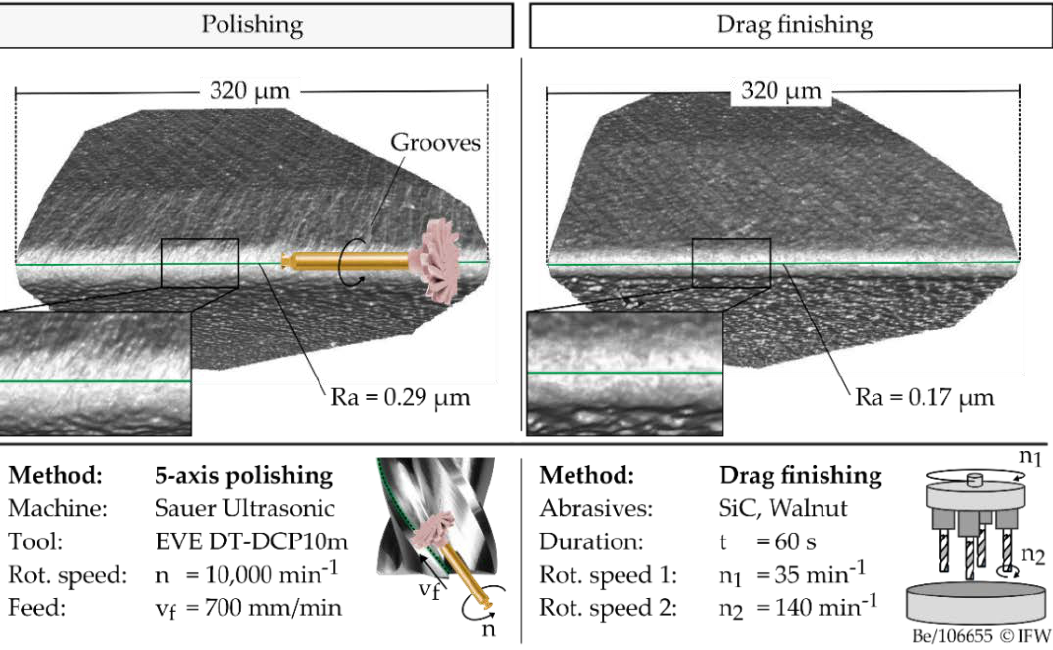
Figure 6. Influence of the preparation methods on the microtopography along the cutting edge.